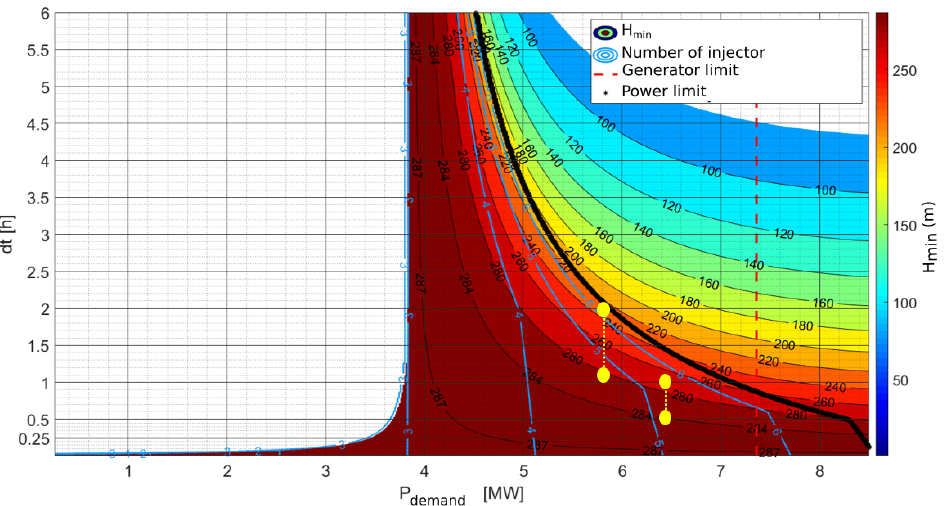
Figure 12. Contours of the available head as a function of the peak duration and the power demand. The thick black line refers to the maximal possible power for a given peak of duration. The yellow dash line represents the trajectory of a possible peak of production. The map is drawn for an inflow discharge at the intake of 1.5 m 3 s − 1